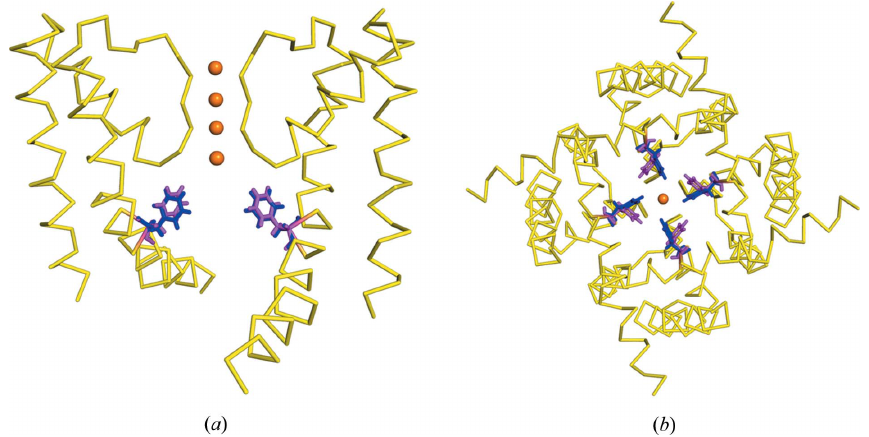
Figure 4 The structure of the NaK2K ion channel is shown as ribbons with the residue Phe92 shown as sticks. The A conformation of Phe92 is shown in magenta while the B conformation of Phe92 is shown in blue, with potassium ions shown as orange spheres. ( a ) Phe92 is located at the bottom of the selectivity filter, for clarity only two of the four subunits that form a complete ion channel are shown. ( b ) A bottom-up view of a complete ion channel, again conformation A of Phe92 is shown in magenta while the B conformation of Phe92 is shown in blue. (Jiang et al. , 2002 a ), which then forms the narrowest part of this ion channel. The distance between the CE atoms of both conformations of Phe92 in our structure is 2.97 A˚ , with the B conformation restricting the size of the pore at the exit of the selectivity filter to 6.55 A˚ compared with a pore diameter of 9.54 A˚ for the more-occupied A conformation (Fig. 5). The A conformation (68% occupancy) corresponds to an enlarged pore conformation of the ion channel in its open form while the B conformation (32% occupancy) corresponds to a restricted form of the open form of the ion channel. We define the pore diameter as the shortest distance between atoms on opposing Phe92 residues in the ion channel based upon our crystal structure.